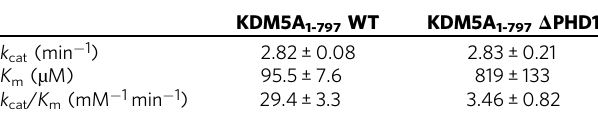
Table 3 Kinetic parameters of KDM5A 1-797 WT and Δ PHD1 constructs reacting with Ac-H3K4me3 21mer